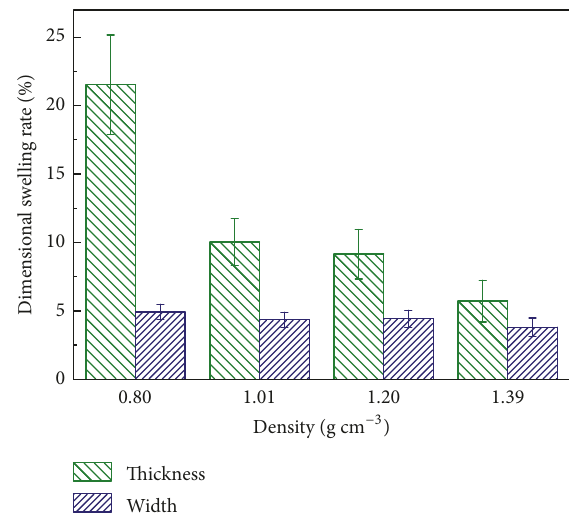
Figure 9: Dimensional swelling rate of scrimbers with different